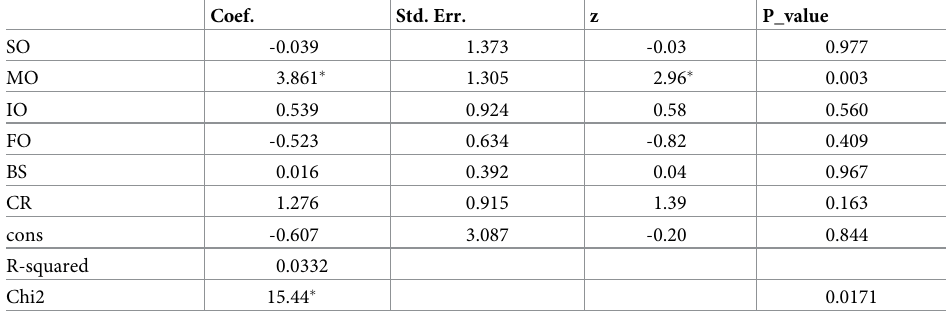
Table 7. Ownership structure and return on